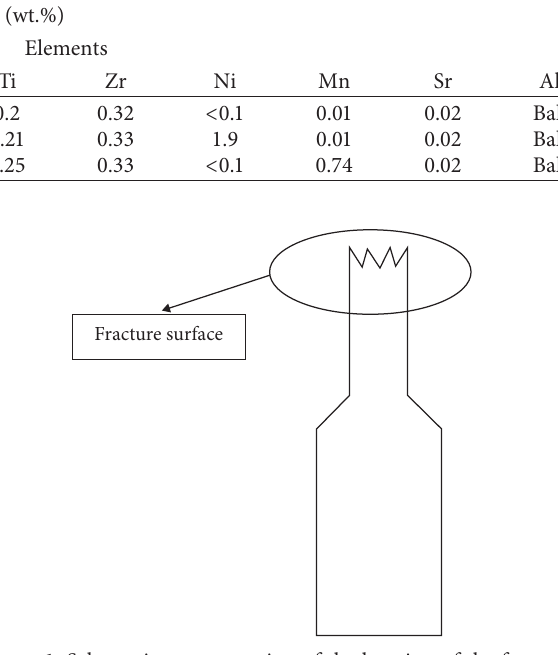
Figure 1: Schematic representation of the location of the fracture